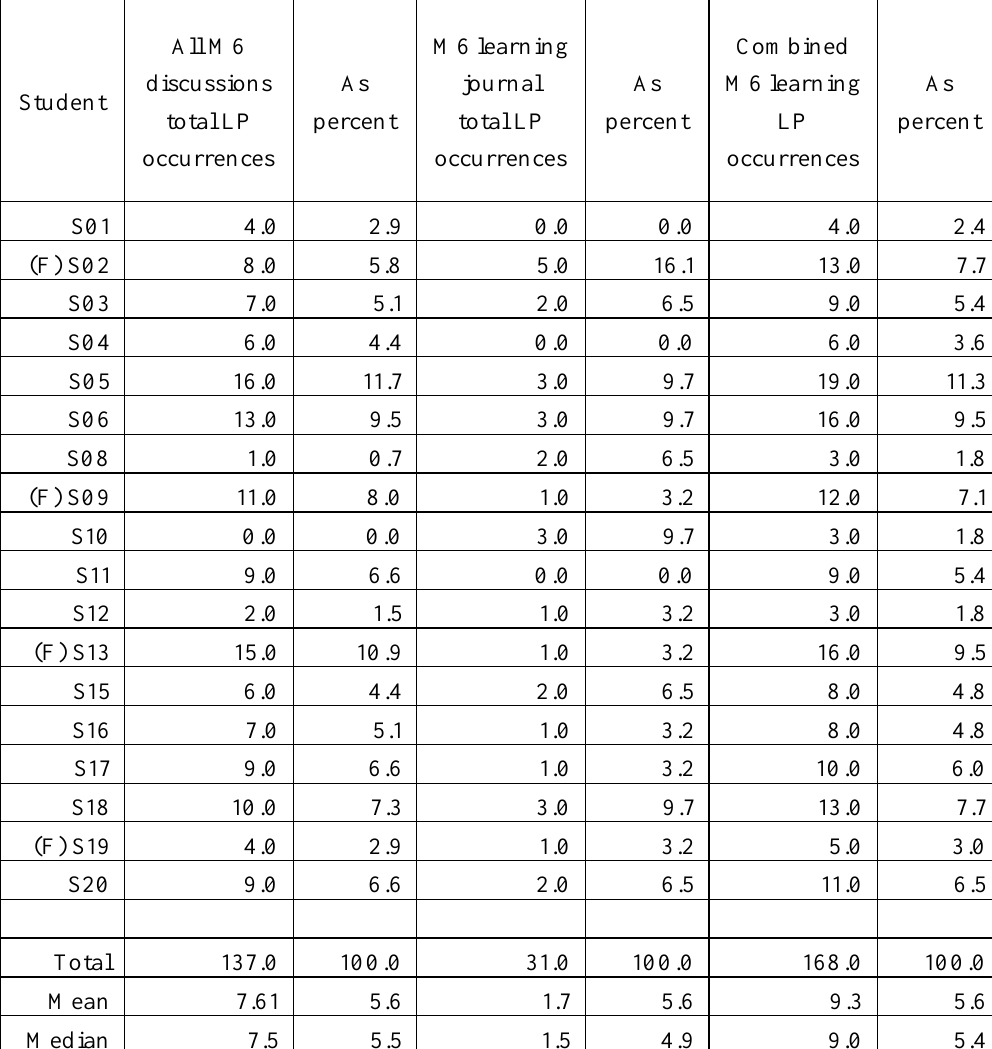
Comparison of LP in Discussions and Learning Journals by